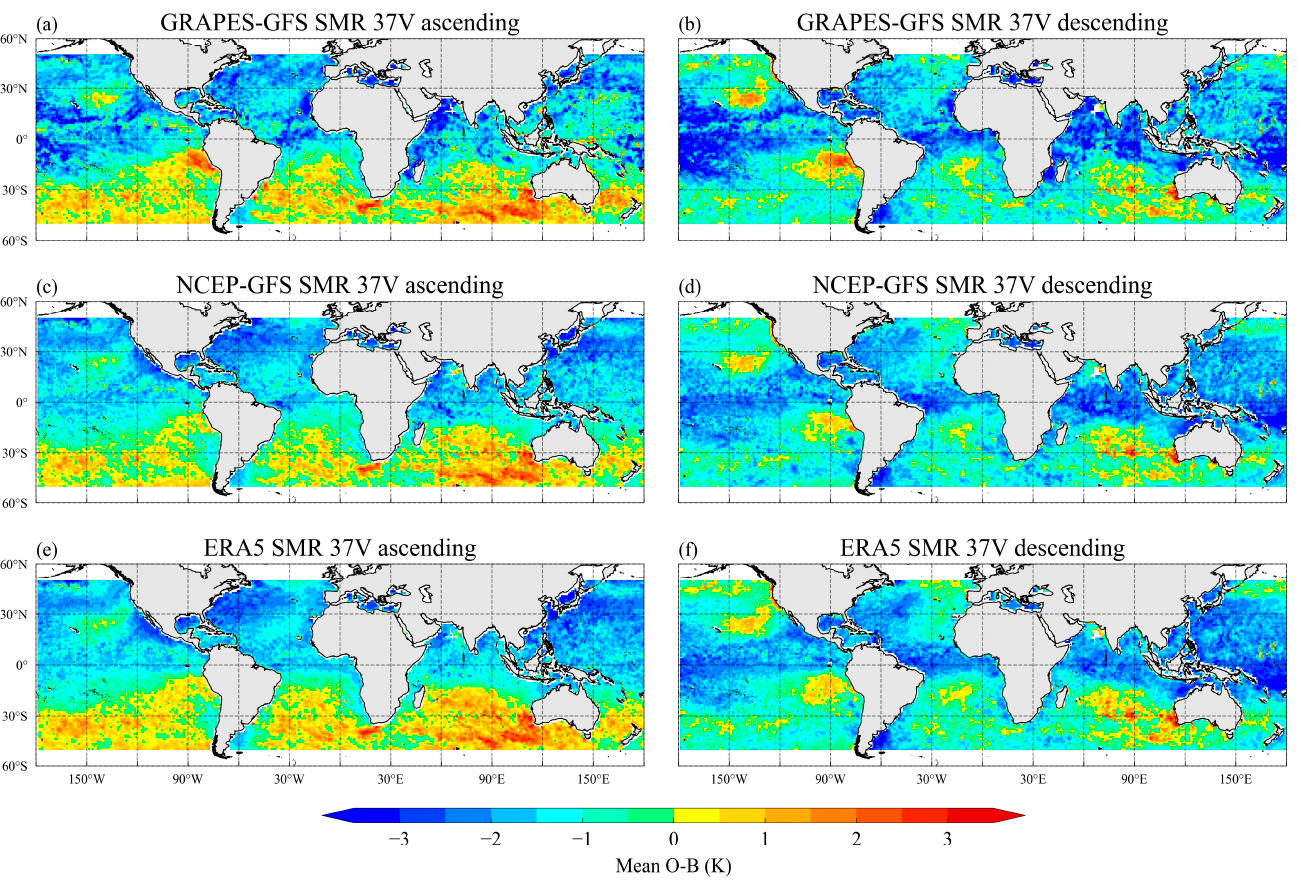
Figure 12. Spatial distribution of O-B over one month (from 10 July 2021 to 10 August 2021) shown for ( a ) GRAPES-GFS, SMR 37 V channel ascending data only, ( b ) GRAPES-GFS, SMR 37 V channel descending data only, ( c ) NCEP-GFS, SMR 37 V channel ascending data only, ( d ) NCEP-GFS, SMR 37 V channel descending data only, ( e ) ERA5, SMR 37 V channel ascending data only, and ( f ) ERA5, SMR 37 V channel descending data only. All statistics are given after applying the QC procedures described in Section 2.4.